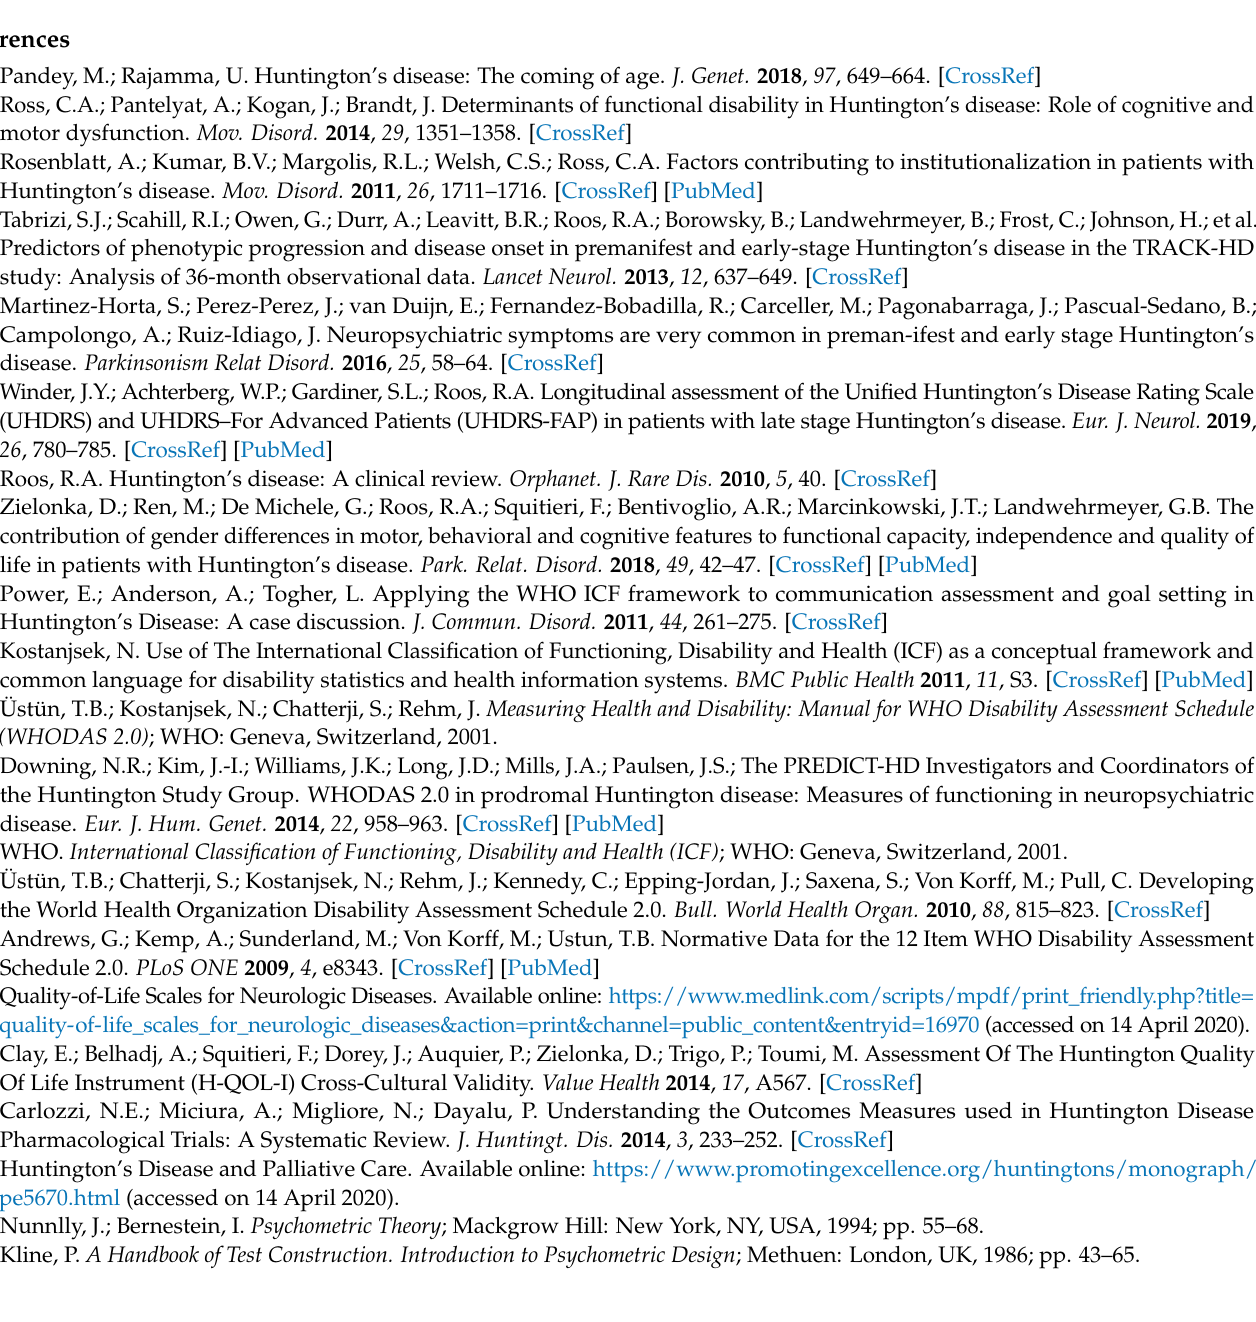
Table S2: Correlations between the WHODAS 2.0 version 12 items and the overall score and